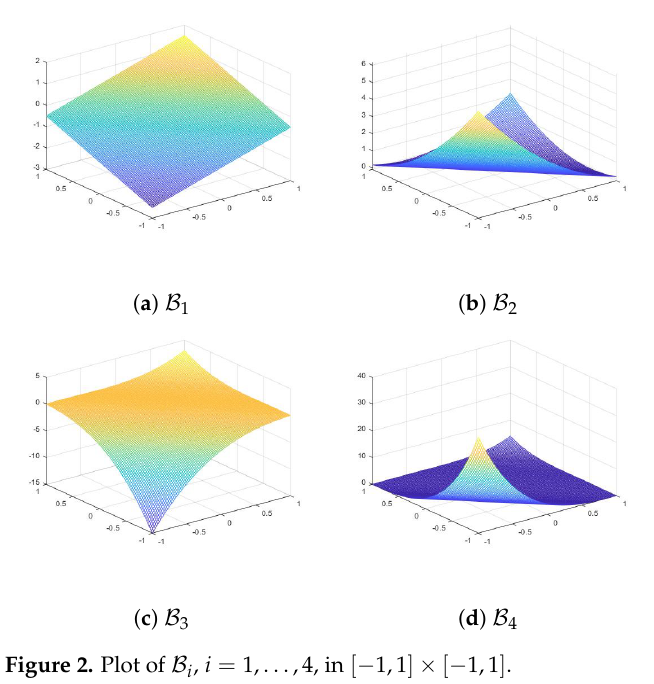
Figure 2. Plot of B i , i = 1, . . . ,4, in [ − 1,1 ] × [ − 1,1 ] . From (11) , (12) and (47) we get α k = B k and β k =